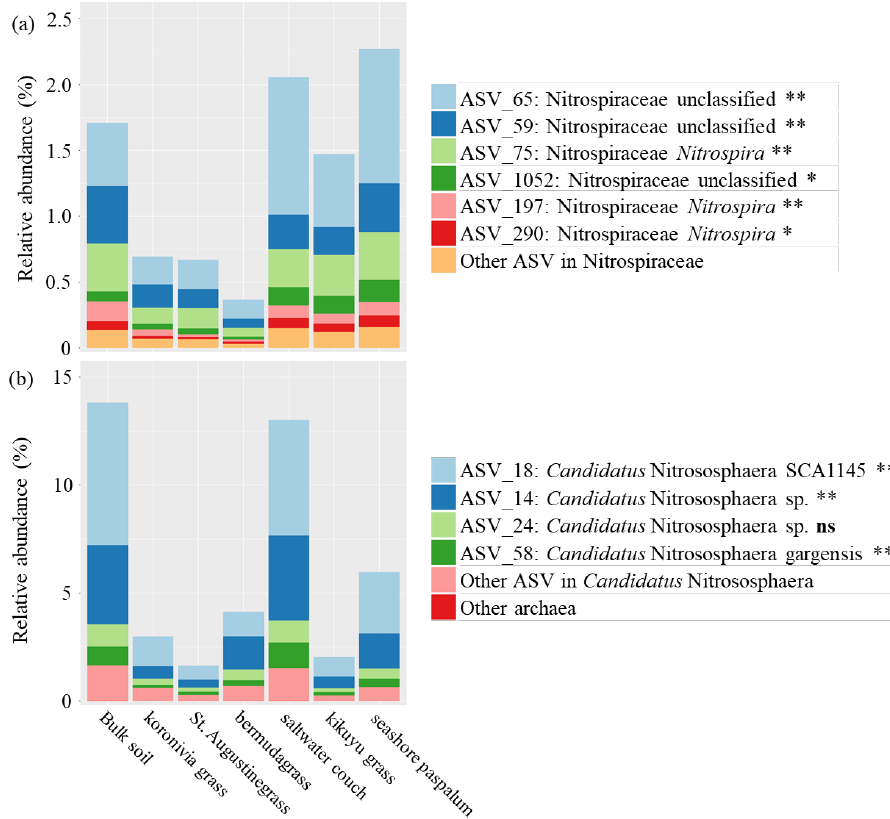
Figure 5. Relative abundance of potential ammonia-oxidizing ( a ) bacteria and ( b ) archaea in bulk soil and rhizosphere soil of six perennial grasses. The effect of treatment was tested as: ns: not significant, *: significant at p < 0.05, and **: significant at p < 0.01. p -values were adjusted by Benjamini–Hochberg FDR.